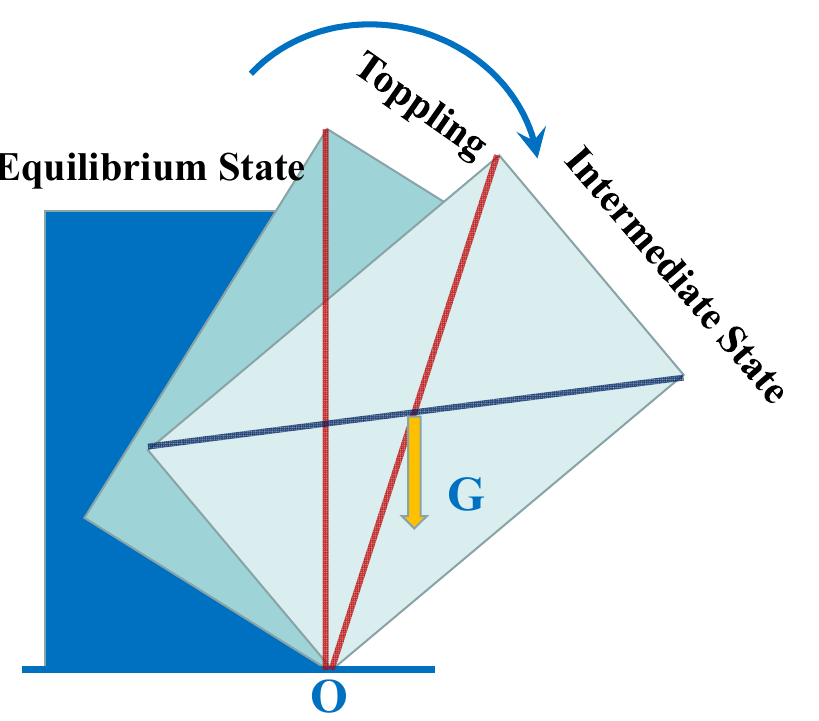
Figure 4. The overturning moment of the high-steep rock slide.